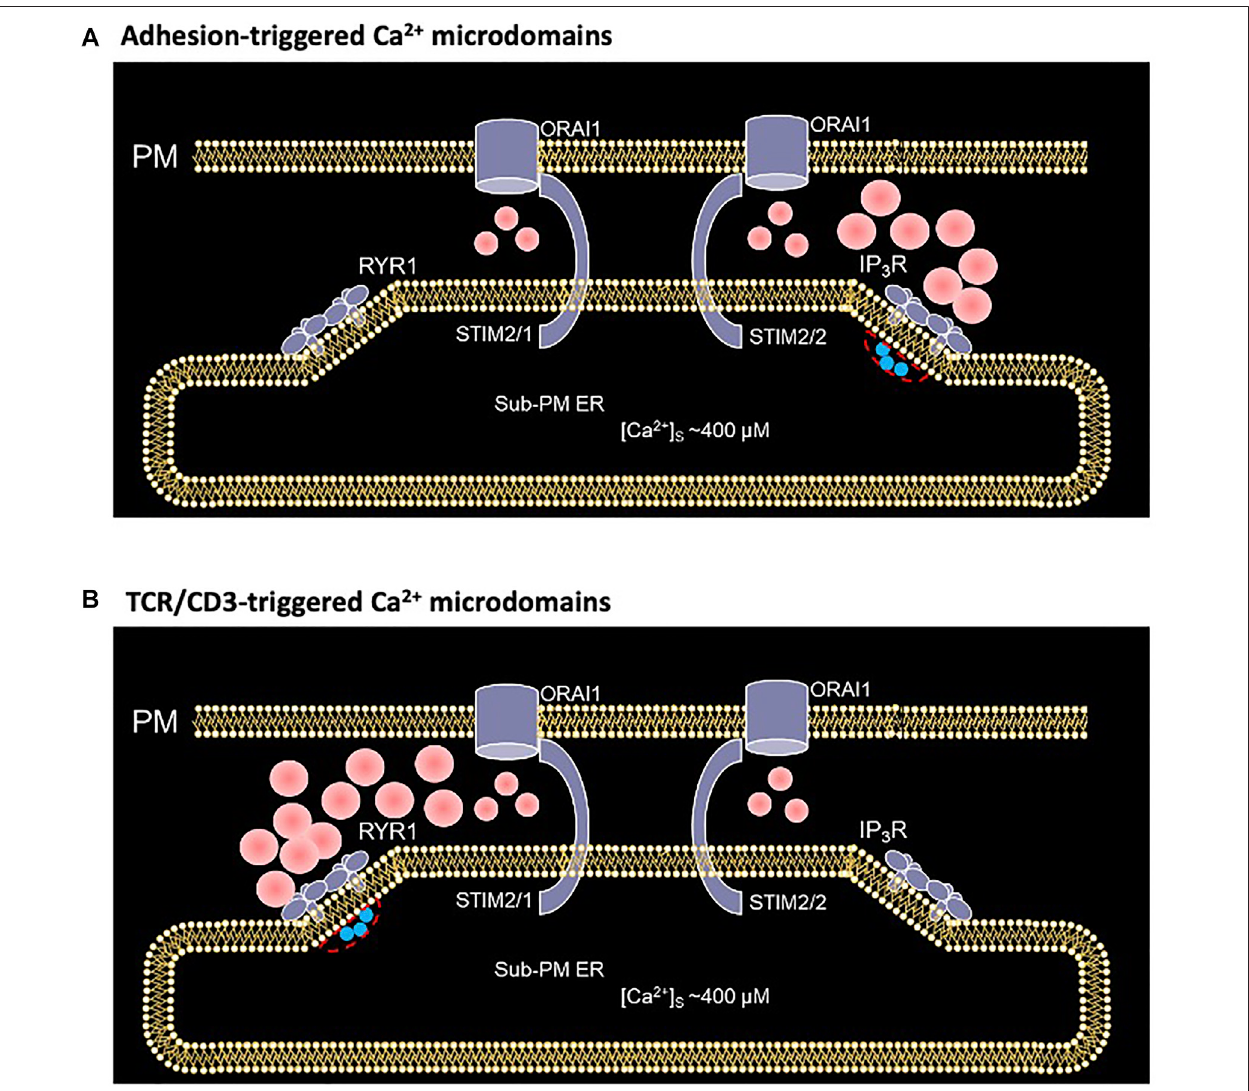
FIGURE 11 | Schematized representation of the proposed mechanism underlying the spontaneous formation of Ca 2+ microdomains in T cells during its transition from quiescent to early activation (A) In an otherwise unstimulated cell, non TCR/CD3 dependent short, spontaneous activation of one or a few IP 3 Rs close to the junction, releases Ca 2+ from the sub-PM ER into the cytosol, leading to further opening of ORAI1 channels most likely bound to STIM2/2 at this stage (Weiss and Diercks, unpublished results) (B) During the fi rst 15 s following TCR/CD3 stimulation, and NAADP driven activation of several RYR1 close to the junction, slightly larger amount of Ca 2+ is released from the sub-PM ER into the cytosol. The resulting local Ca 2+ depletion close to the RYR1 pore provokes the unbinding of Ca 2+ from STIM1/2 heterotetramers, which further activates ORAI1 channels (Diercks et al., 2018). Red spots represent Ca 2+